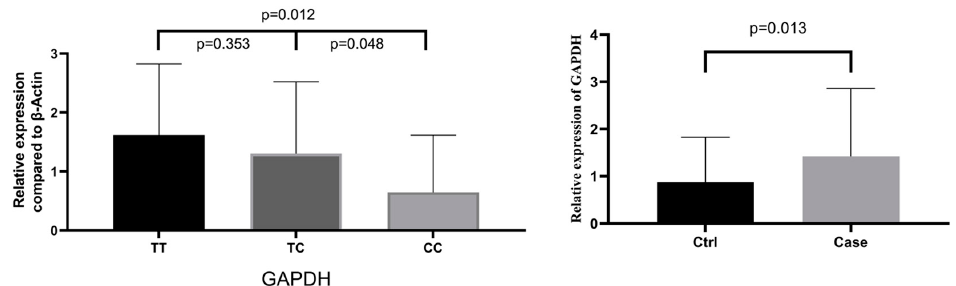
Figure 4. Relative GAPDH expression levels according to the rs6489721 genotype and presence of NIHL.